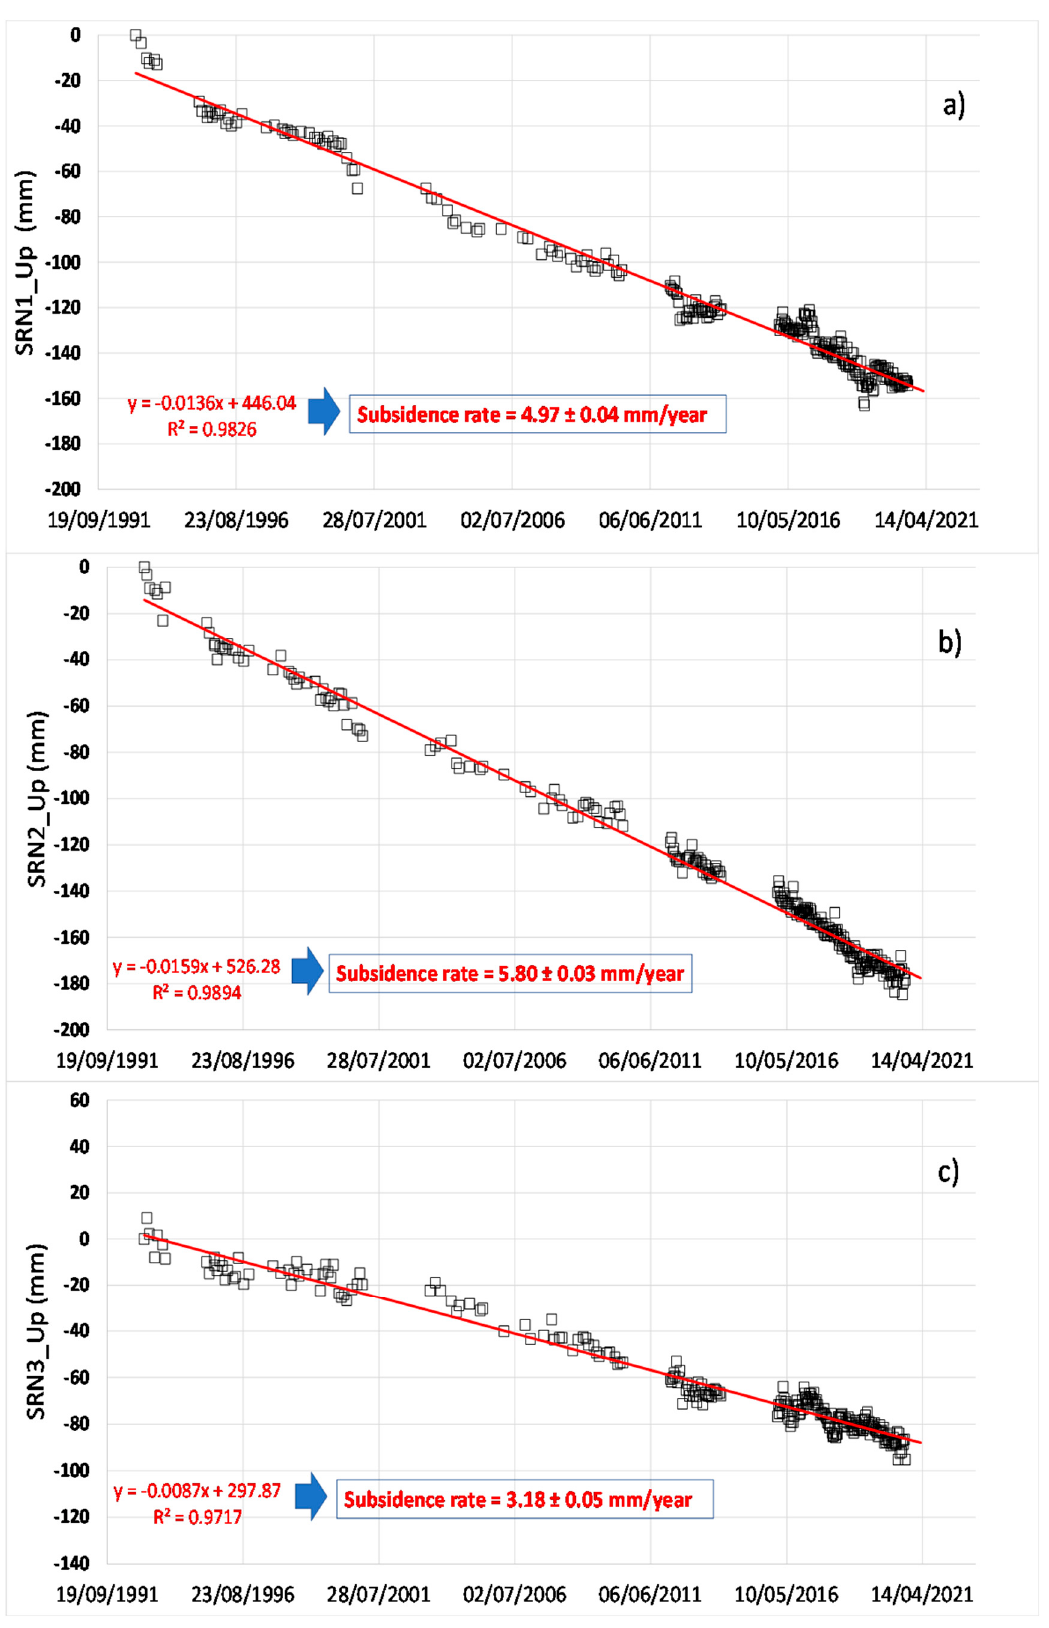
Figure 13. Time series of the DInSAR data (up component) used to characterise the vertical displacements within the Sarno basin ( a – c ). Refer to Figure 11 to locate the selected points.